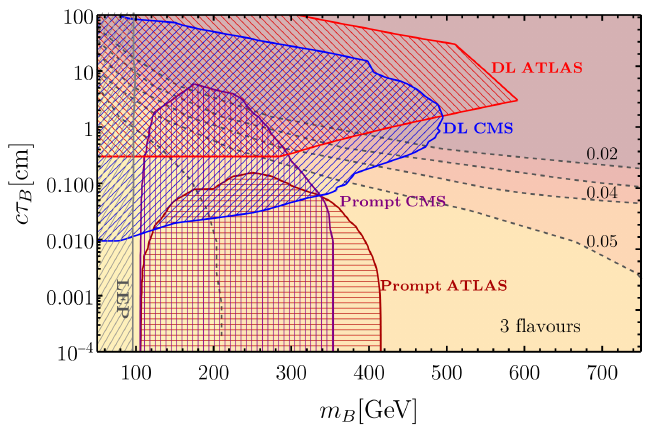
Figure 3 . Collider constraints on the parameter space of interest for the 3-flavour case ( y e = y µ = y τ = y